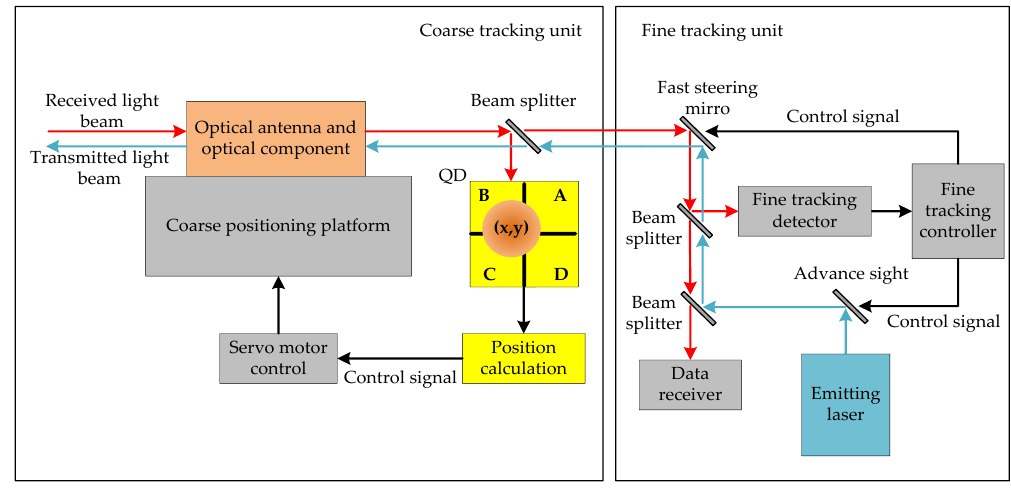
Figure 1. The no independent beacon light acquisition, tracking, and aiming (ATP) system.